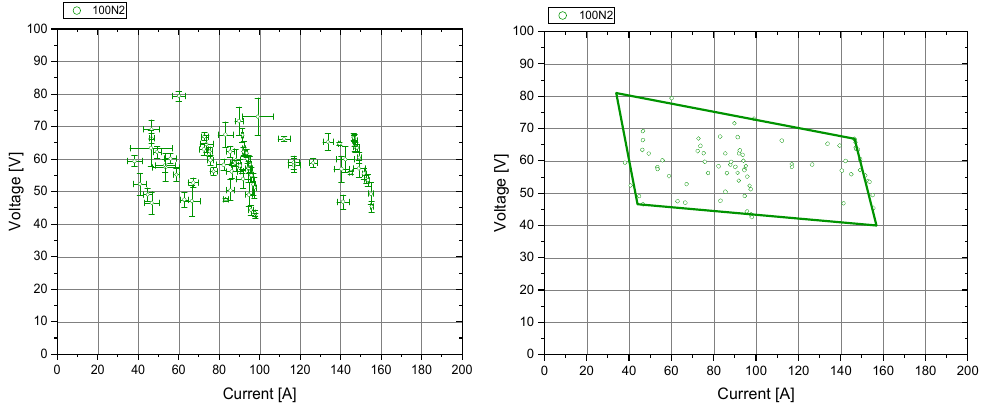
Figure 15. Example of the evaluation of the field of stability for 100% nitrogen.